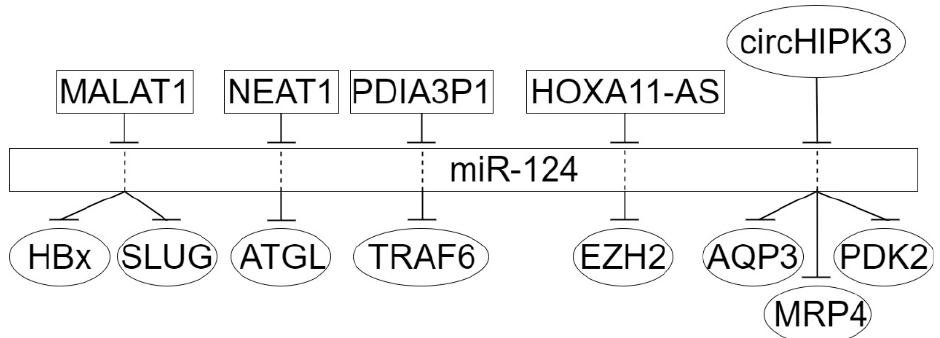
Figure 3. MiR-124 regulatory sub-network in hepatocellular carcinoma. LncRNAs are given inside the rectangles, circRNAs are in ovals at the top, protein targets are in ovals at the bottom.